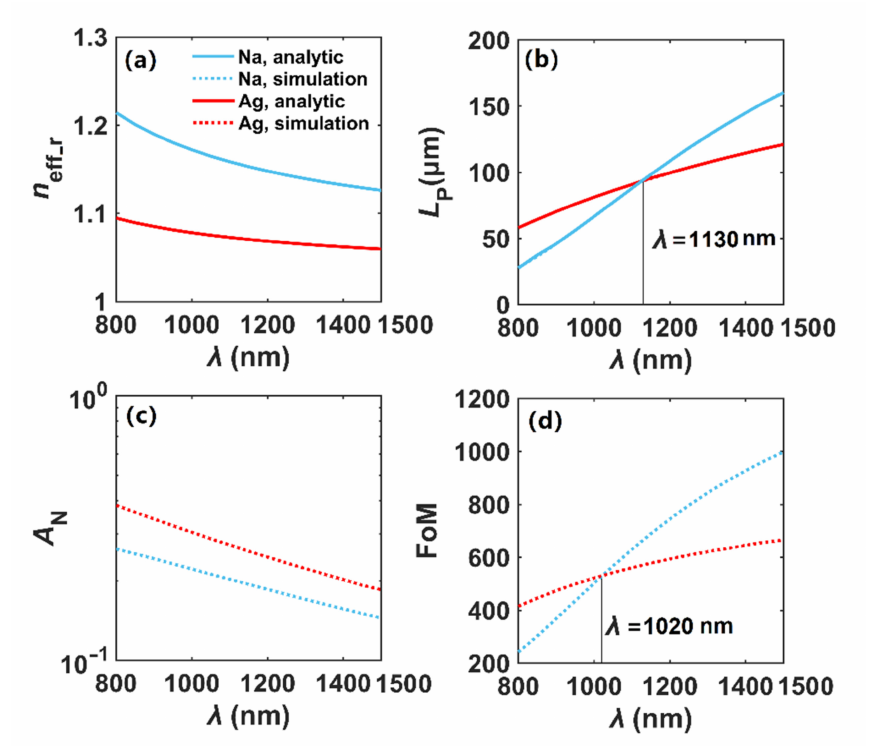
Figure 4. Modal properties of single Na and Ag nanowires in vacuum. ( a ) n eff_r , ( b ) L P , ( c ) A N , ( d ) FoM. Analytical results of n eff are obtained from Equation (2) of Ref. [4].